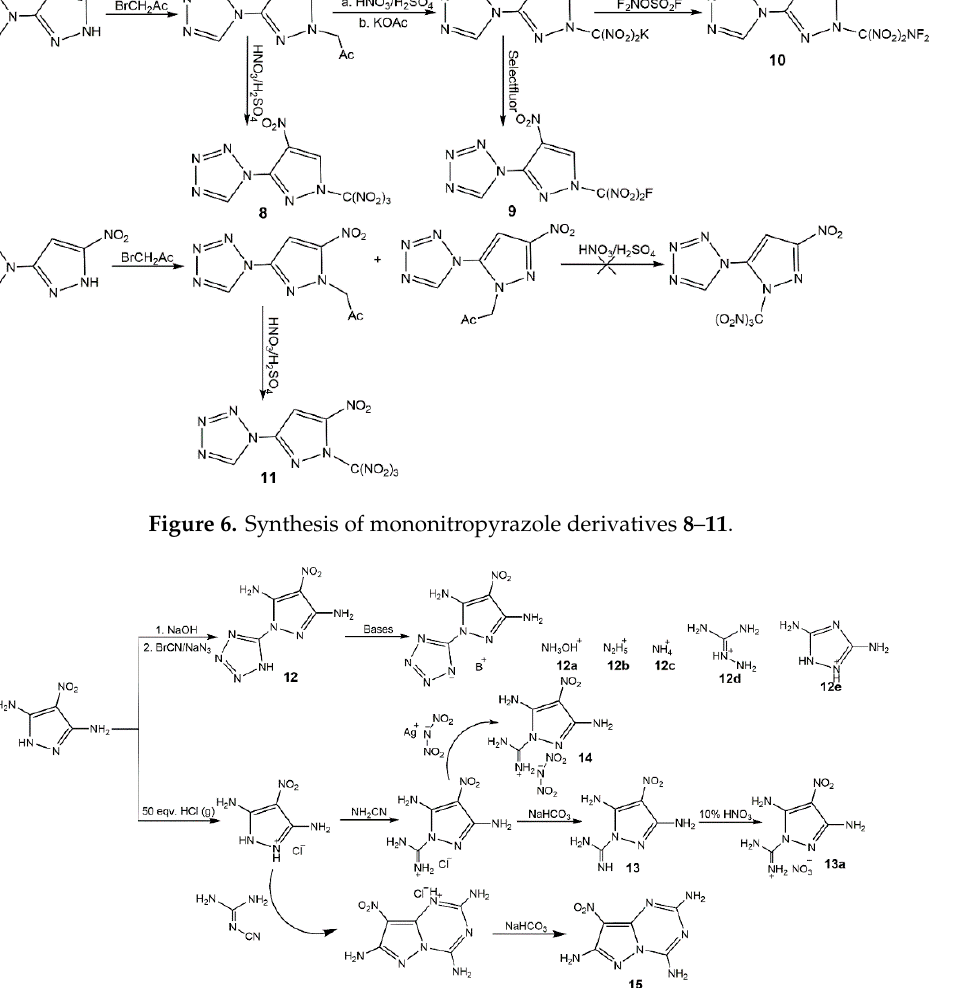
Figure 7. Synthesis of mononitropyrazole derivatives 12 – 15 .